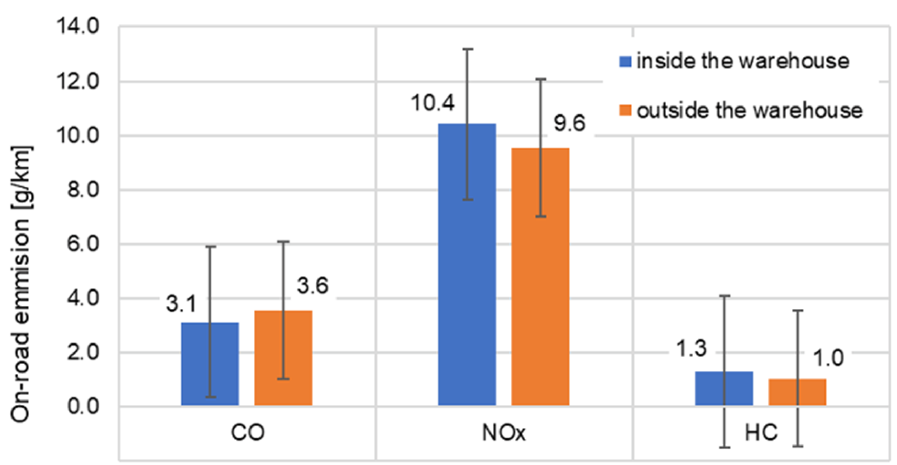
Figure 5. Comparison of the road emissions of individual exhaust components relevant to the handling location.